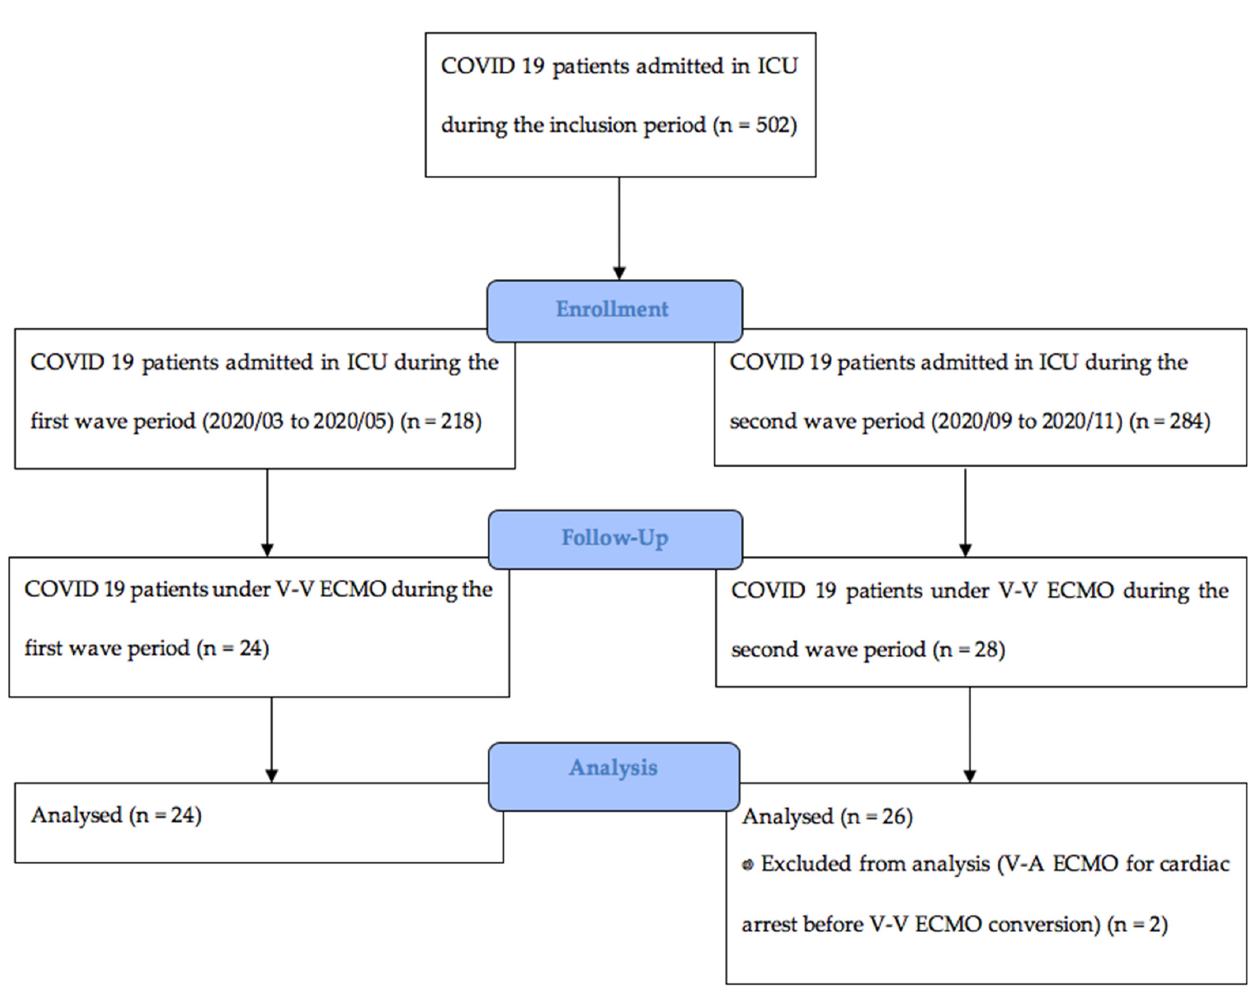
Figure 1. Flow chart of the study. V-V ECMO: veno-venous extracorporeal membrane oxygenation. V-A ECMO: veno- arterial extracorporeal membrane oxygenation.